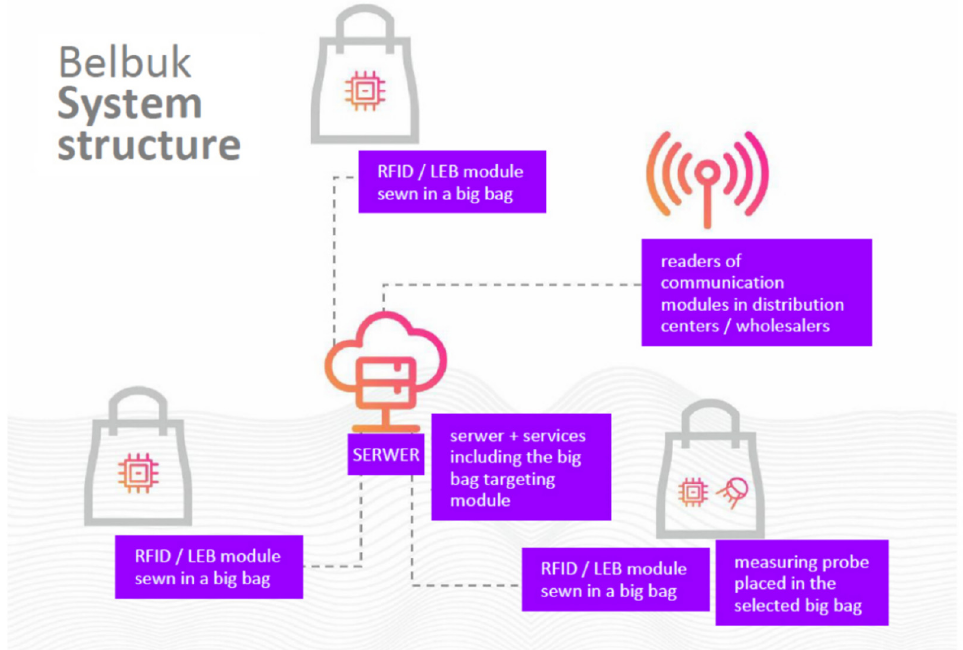
Figure 2. Structure of the Belbuk system.